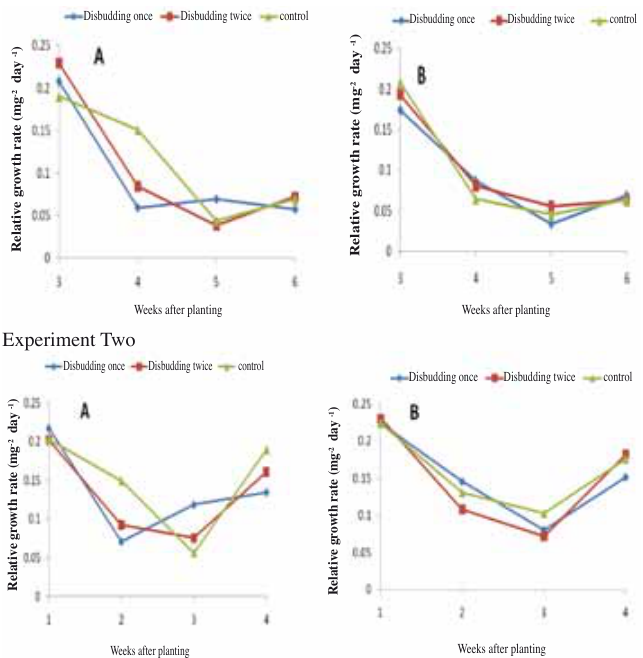
Fig. 5 - Relative growth rate as affected by disbudding and cultivar: ‘Carmine’ (A) and ‘Chief Gold’